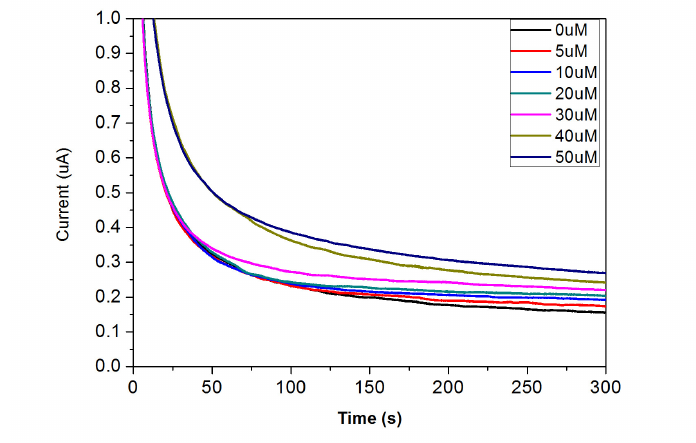
Figure 11. Amperometric response of the disposable biosensor to different DG concentrations in 1:1 bovine serum-buffer medium.